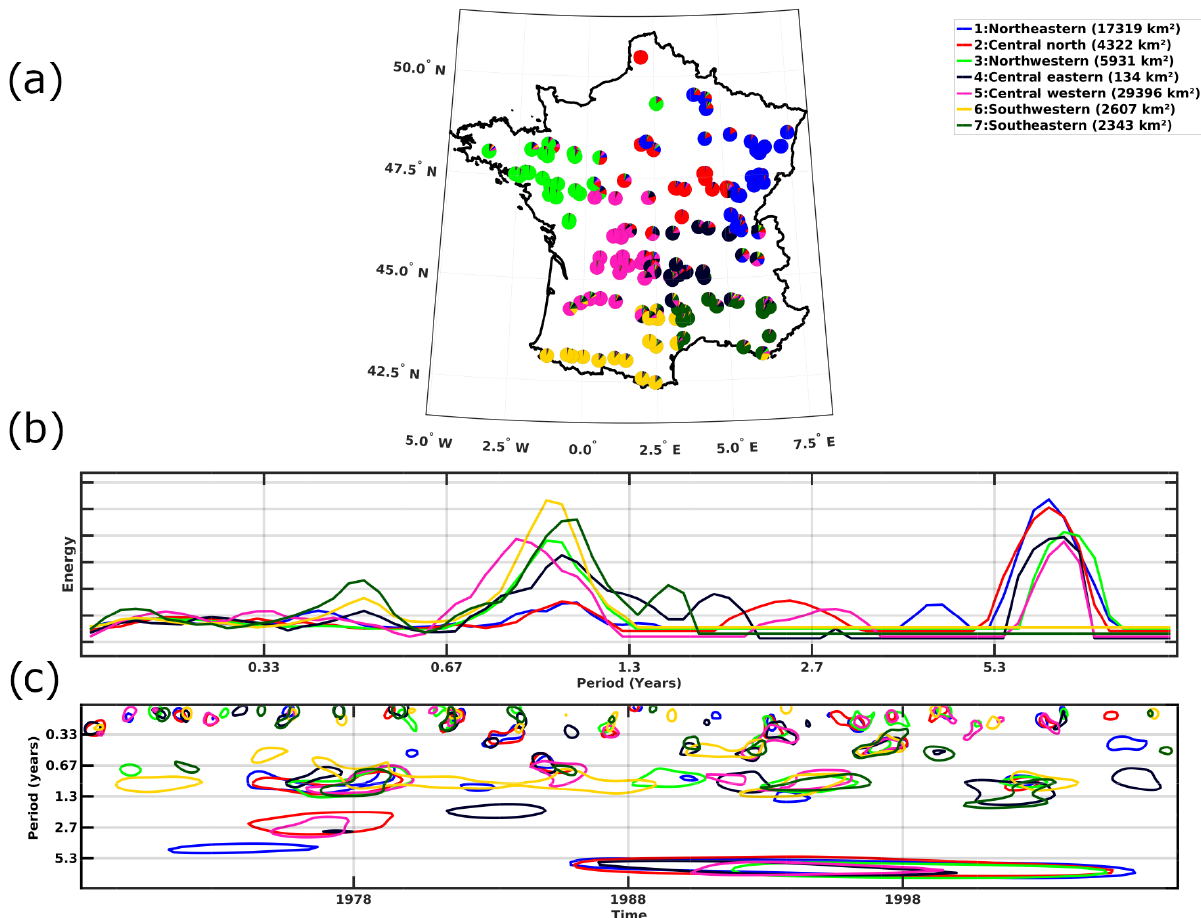
Figure 4. Clustering of precipitation time frequency variability in France. (a) Classification map of the watersheds. Pie chart slices show the three highest probability memberships. Pie charts denote fuzzy clustering memberships. (b) Global wavelet spectra of homogeneous regions. (c) Wavelet spectra of homogeneous regions. For clarity, only timescales and time locations that are 95% statistically significant and with the largest variability are shown (colored